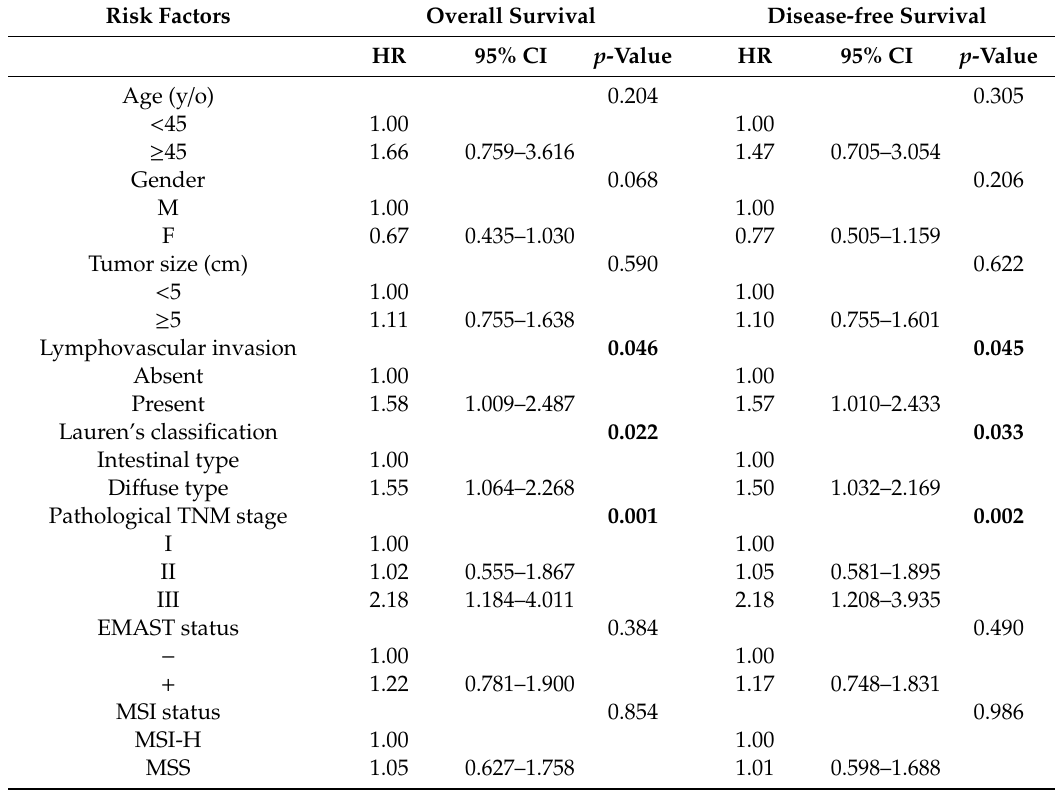
Table 7. Multivariate Cox proportional-hazards model for the analysis of the overall survival and disease-free survival for gastric cancer patients after curative